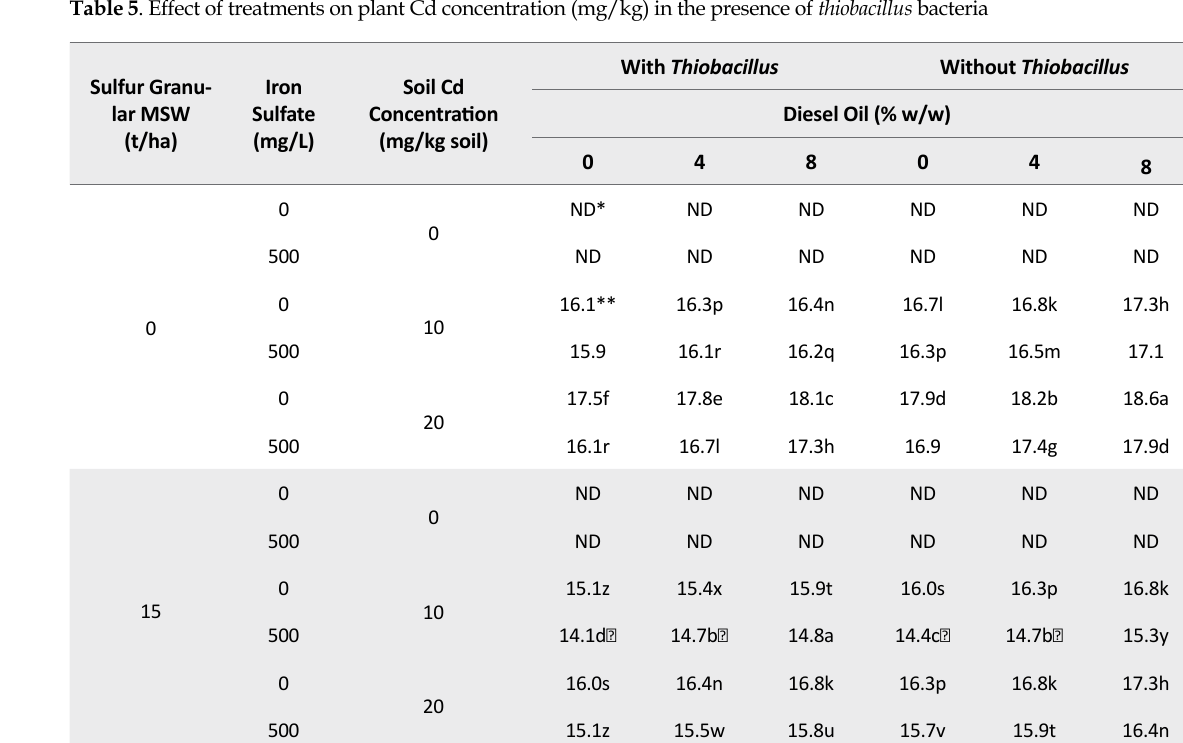
Table 5 . Effect of treatments on plant Cd concentration (mg/kg) in the presence of thiobacillus bacteria